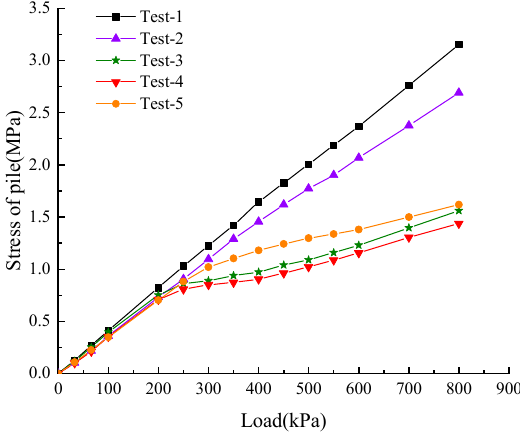
Figure 4. Curve of load–pile top stress.